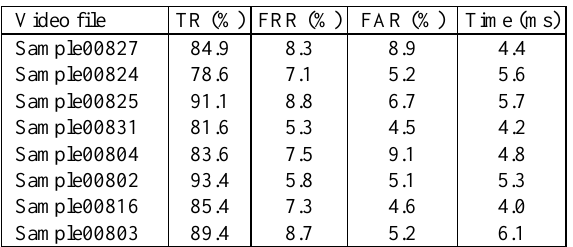
Gesture recognition results representing in Table 3 demonstrate the dependence from more simple or complex trajectory of dynamic gesture and visible shape of a hand. In spite of all difficulties, the final results are promising due to the analysis of a sequence of sub-gesture descriptors, which represent a single dynamic gesture. The temporal estimators show a possibility of real-time implementation of the designed software